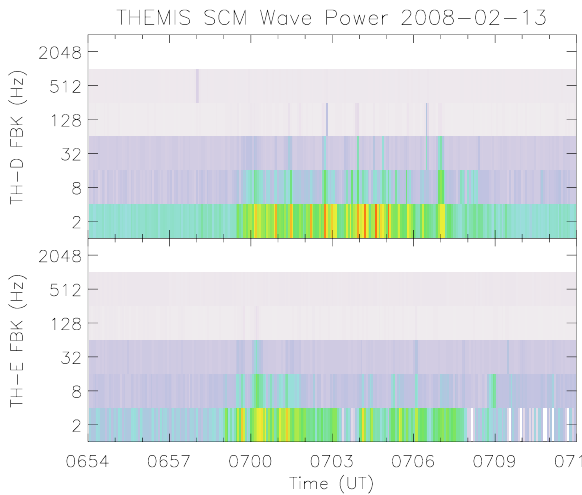
Fig. 8. THEMIS SCM measurements of the high-frequency wave power on TH-D (upper panel) and TH-E (bottom